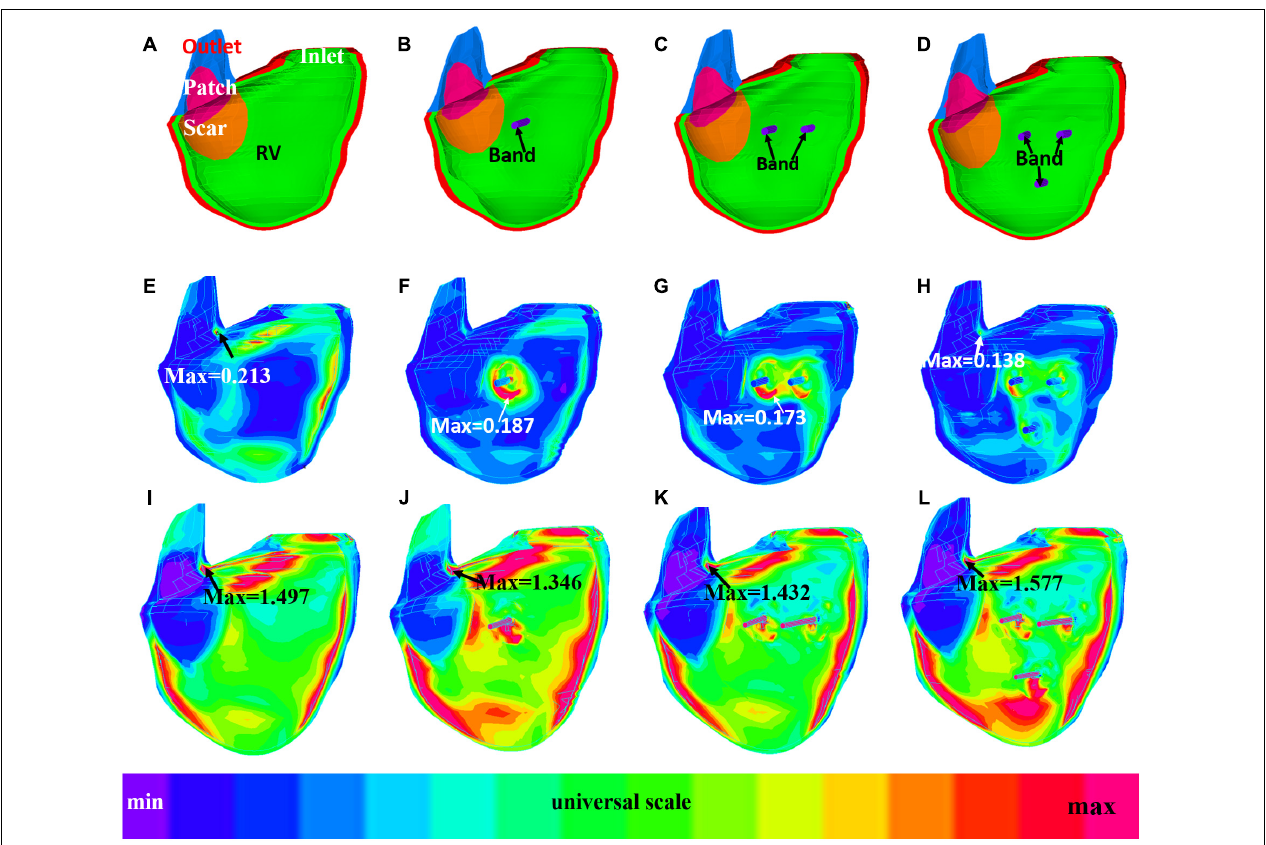
FIGURE 7 | Strain plots of patient 5 from the no-band model and three active band models with band contraction ratio of 20%. (A) Model with no band, zero load. (B) Plan A: model with one band, zero load. (C) Plan C: model with two bands, zero load. (D) Plan E: model with three bands, zero-load. (E) Model with no